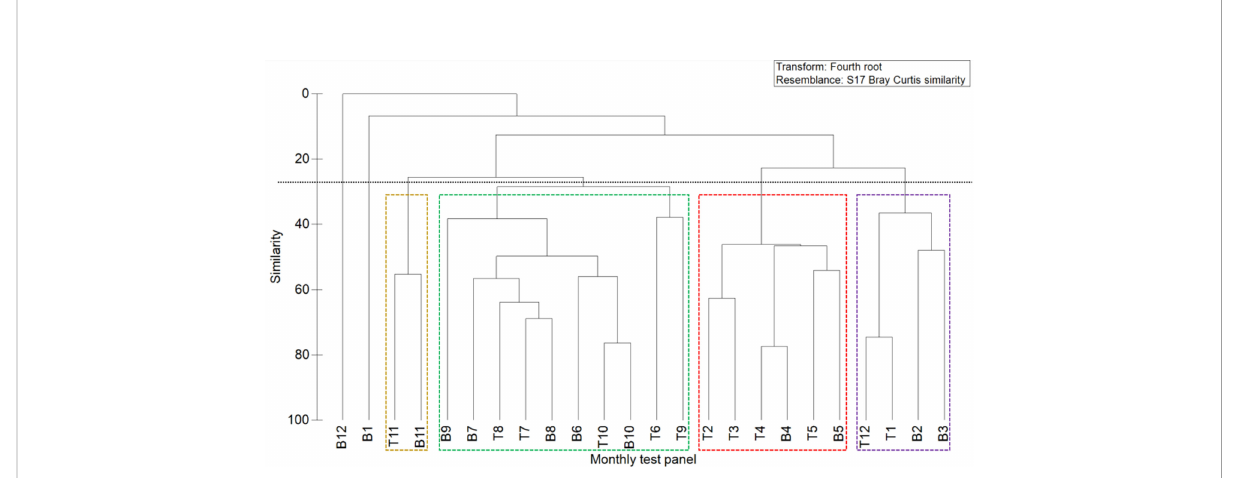
FIGURE 10 Clustering of the Bray – Curtis similarity of the marine fouling communities on monthly test